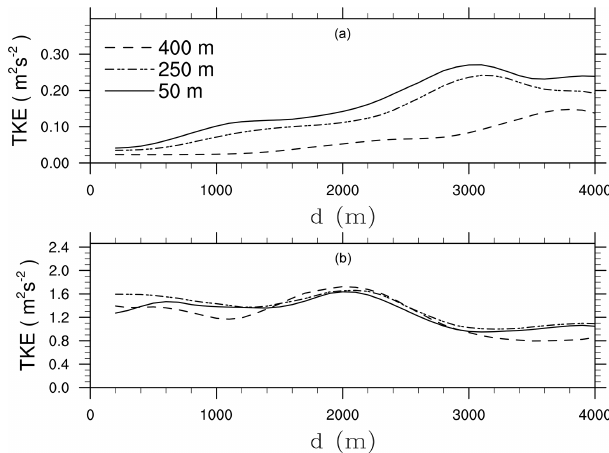
Figure 8. Horizontal profiles of 30min time-averaged resolved- scale turbulent kinetic energy (TKE) in the parent domain plotted against distance from the inflow boundary ( d ) for (a) the winter case at 14:00UTC on 5 December and (b) the summer case at 13:00UTC on 20 July. The TKE is shown for heights at 50, 250, and 400m above the terrain